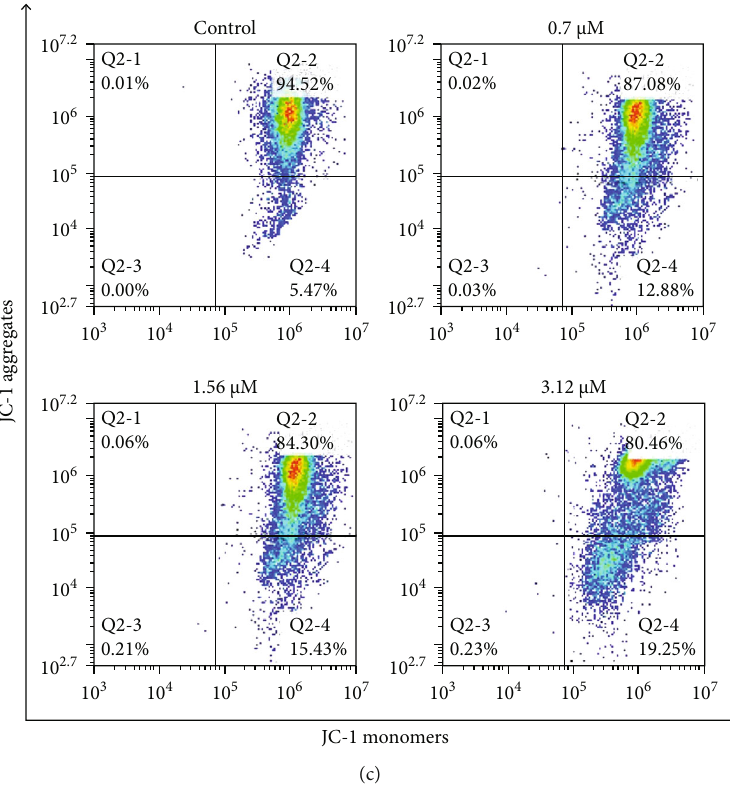
Figure 3: E ff ect of shikonin on cell apoptosis. (a) Shikonin-induced apoptosis in H1299 cells was characterized by nuclear condensation or nuclear fragmentation after Hoechst staining. (b) Flow cytometric analysis of shikonin-induced apoptosis in H1299 cells. The fl ow cytometry pro fi le presents Annexin V FITC ( x -axis) and PI staining ( y -axis). The values represent the percentage of cells in each of the four quadrants (lower left quadrant, viable cells; upper left quadrant, necrotic or dead cells; lower right quadrant, early stage apoptotic cells; and upper right quadrant, late stage apoptotic cells). (c) The mitochondrial membrane potential ( Δψ m) was assessed using fl ow cytometry following the treatment of H1299 cells with shikonin (0.78, 1.56, or 3.12 μ M) for 48